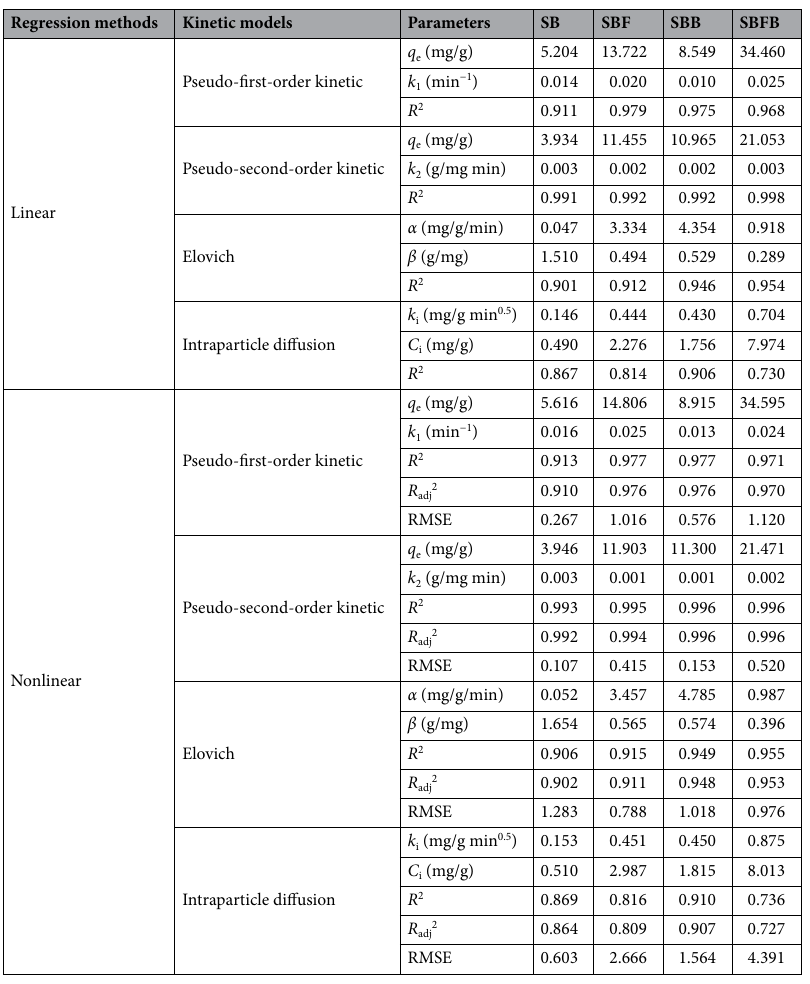
Table 5. The comparison of linear and nonlinear kinetic parameters for lead adsorptions on sugarcane bagasse powder (SB), sugarcane bagasse powder doped iron(III) oxide-hydroxide (SBF), sugarcane bagasse powder beads (SBB), and sugarcane bagasse powder doped iron(III) oxide-hydroxide beads